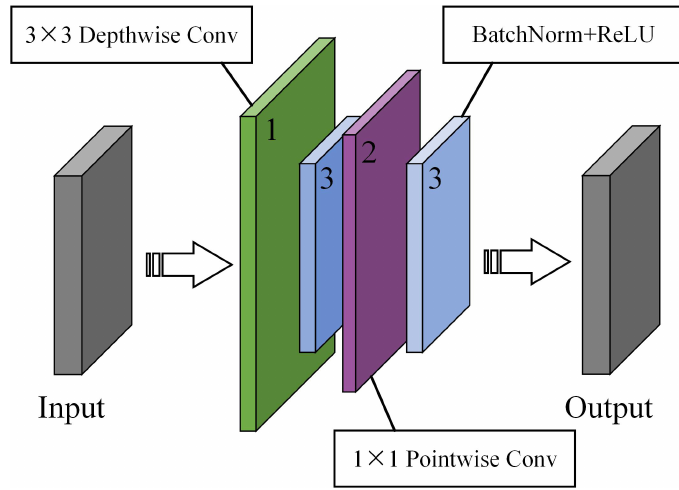
Figure 5. The structure of depth-wise separable